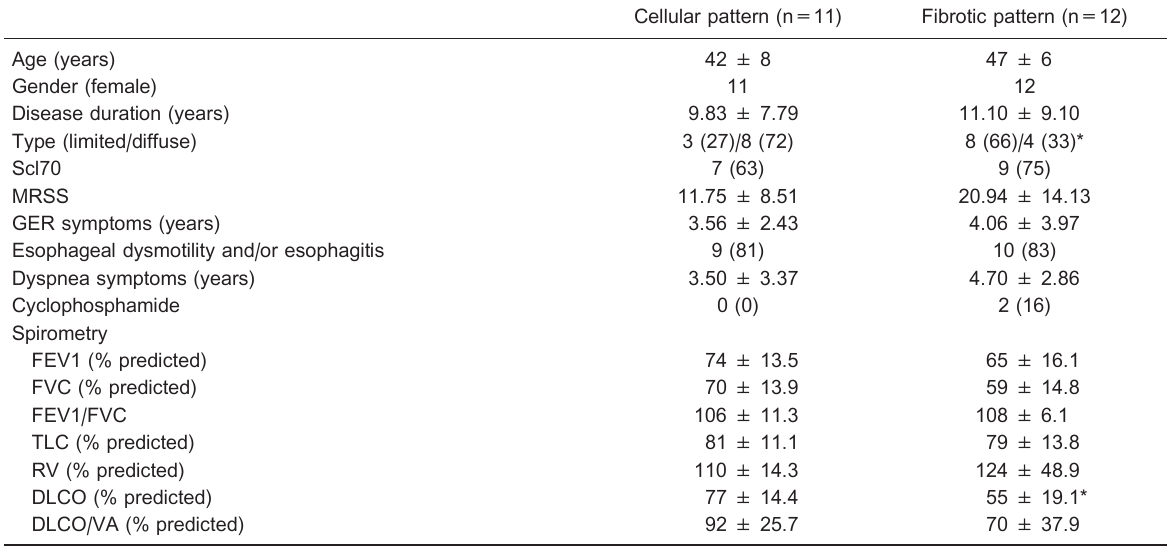
Table 1. Demographic, clinical and laboratory features of systemic sclerosis patients of the cellular and fibrotic